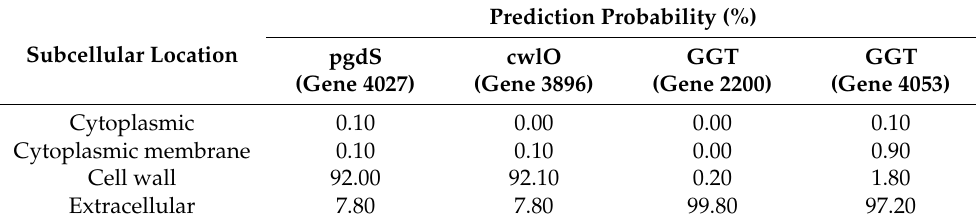
Table 5. Subcellular location analysis of γ -PGA degrading enzymes by